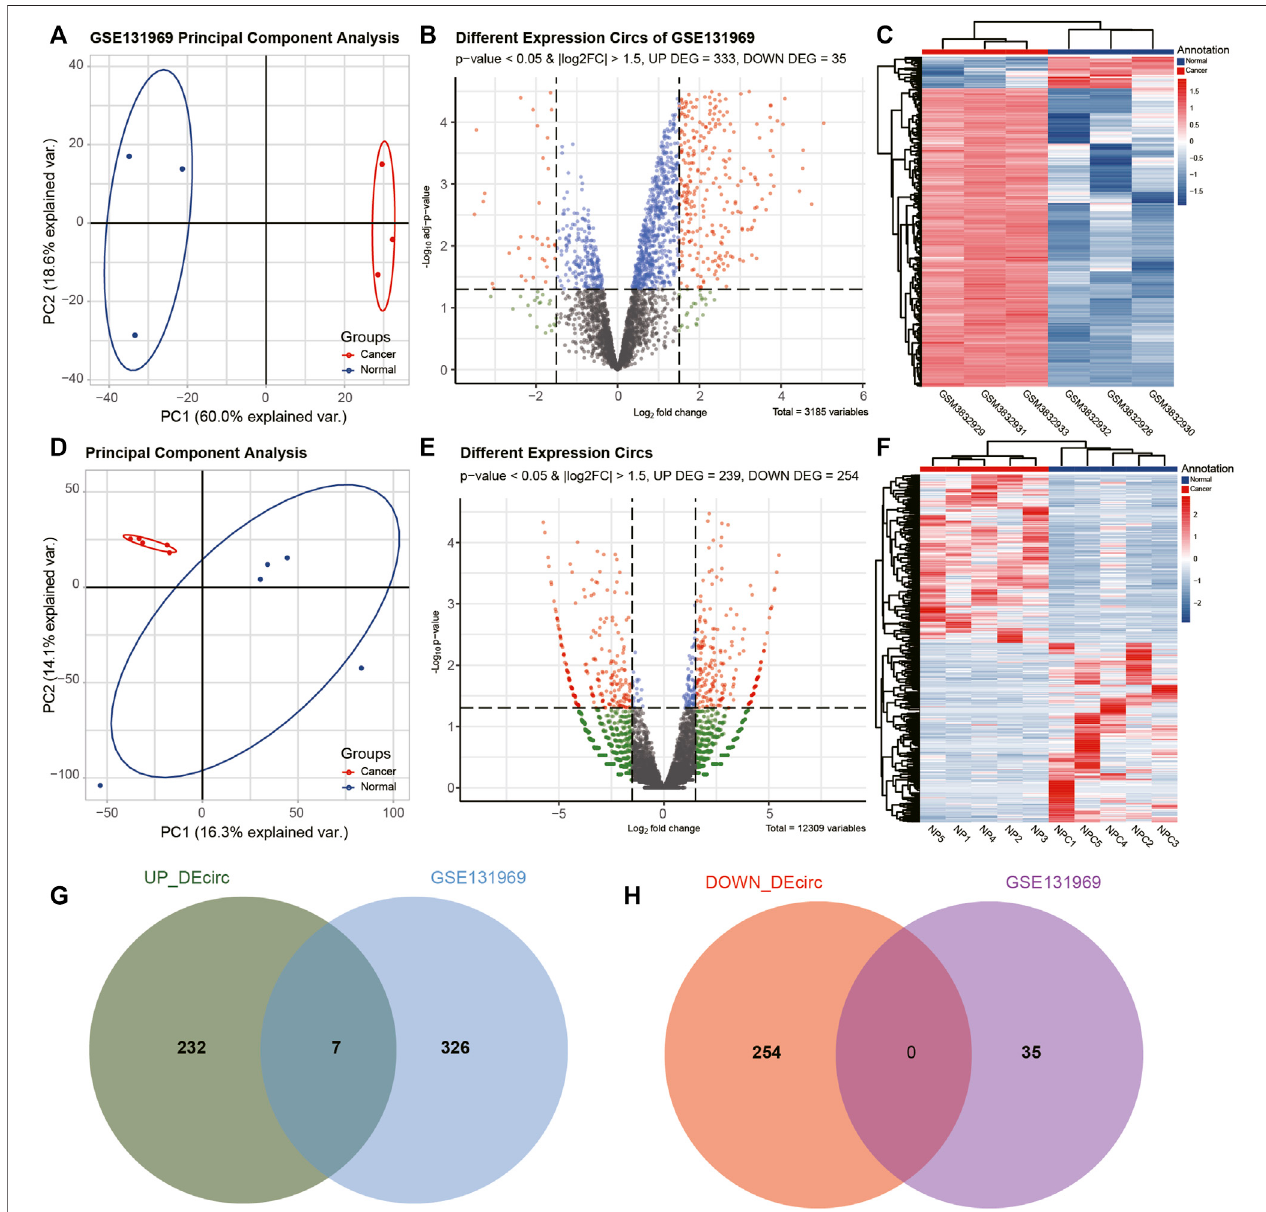
FIGURE 1 | Identi fi cation of differentially expressed circRNAs (DEcircRNAs) in esophageal cancer (ECA). (A, D) Principal component analysis (PCA) of circRNA expression between ECA and normal groups in GSE131969 and the present RNA-sequencing (RNA-seq) data. (B, E) Volcano plot of the distributions of all DEcircRNAs in GSE131969 and the current RNA-seq data. (C, F) Hierarchical clustering heatmap of dysregulated circRNAs between ECA and the adjacent normal tissues in GSE131969 and the present RNA-seq data. (G, H) Comparison of differentially expressed circRNAs identi fi ed in GSE131969 and our RNA-seq